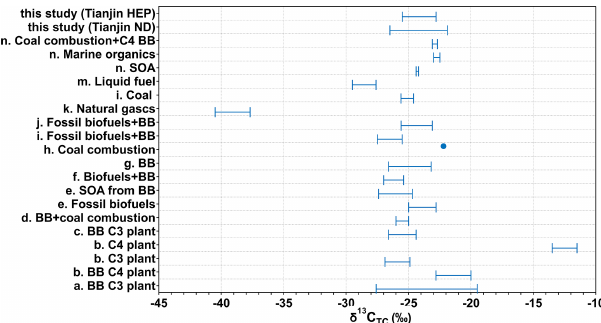
Figure 9. Range or mean δ 13 C TC in the particles emitted from point sources, source substances and atmospheric aerosols from dif- ferent sites around the world. (a) Cao et al. (2016); (b) Martinelli et al. (2002); (c) Song et al. (2018); (d) Garbaras et al. (2015); (e) Bikkina et al. (2016); (f) Aggarwal et al. (2013); (g) Fu et al. (2012); (h) Kunwar et al. (2016); (i) Cachier et al. (1986); (j) Pavuluri and Kawamura (2016); (k, l, m) Widory (2007); (n) Kundu et al.